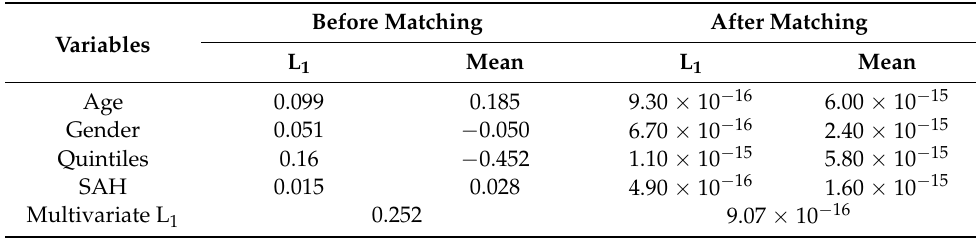
Table 1. The L 1 measure of imbalance before and after CEM.